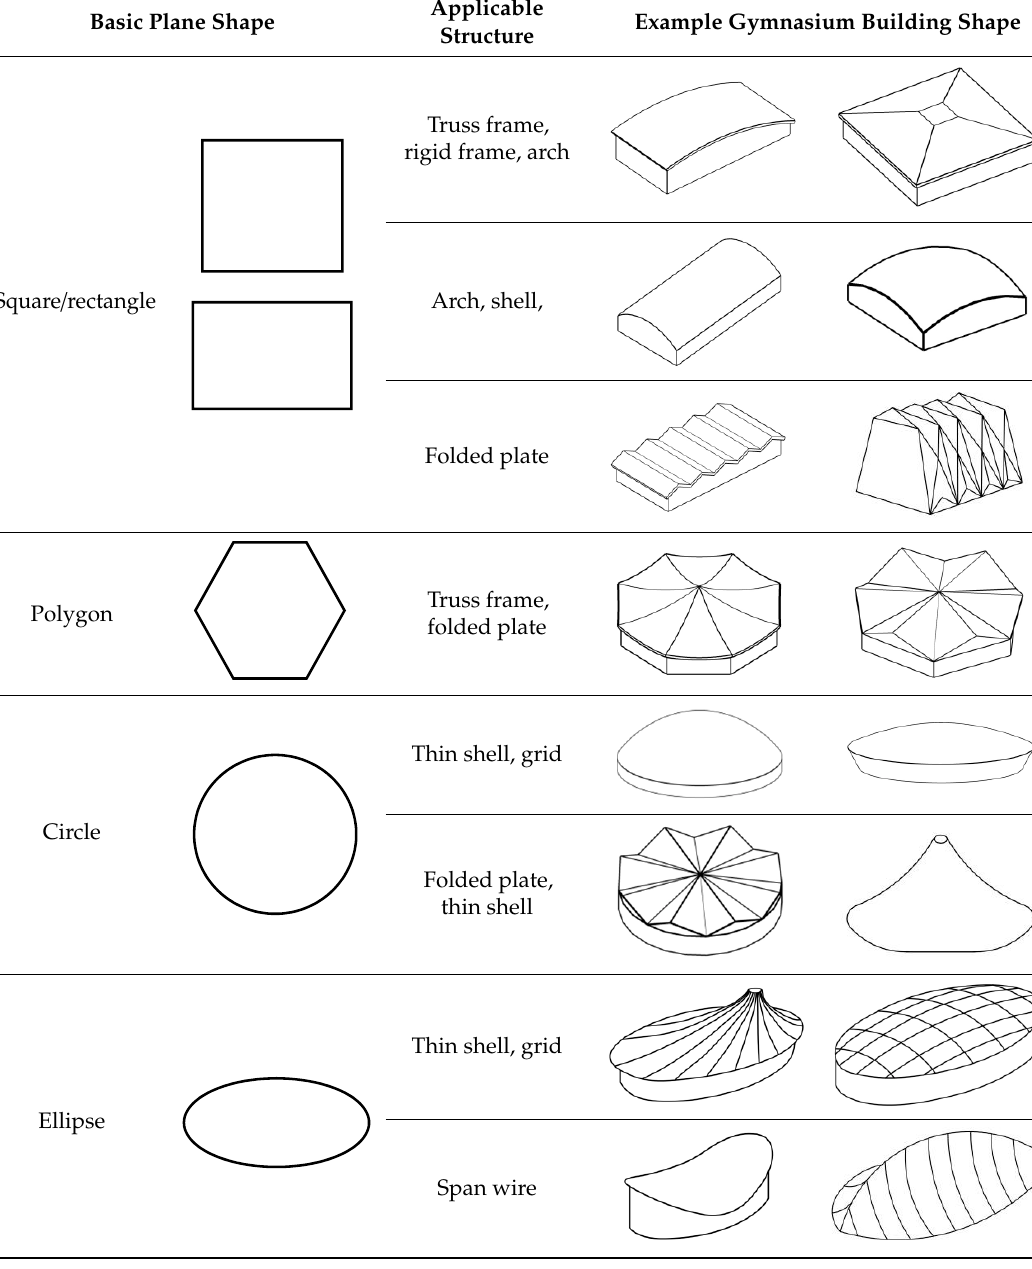
Table 1. Examples of gymnasium building shapes based on the typical plane shape [27].